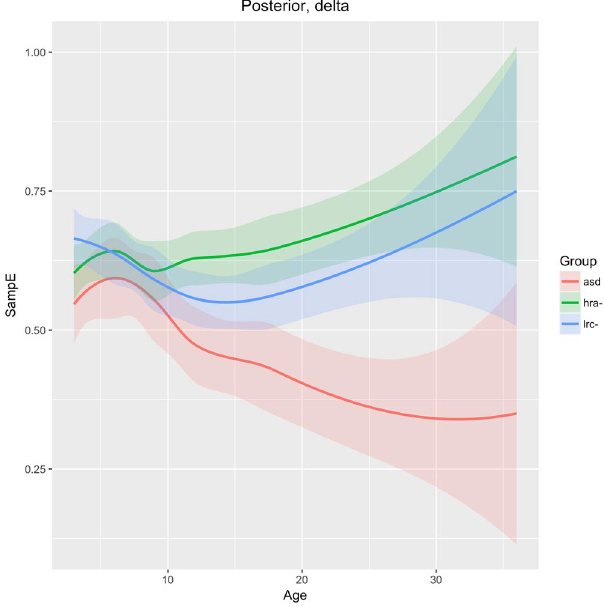
Figure 12. Developmental trajectories of SampE for the posterior region (O1 + O2 sensors) in low frequency (delta) for ASD, LRC − , and HRA −